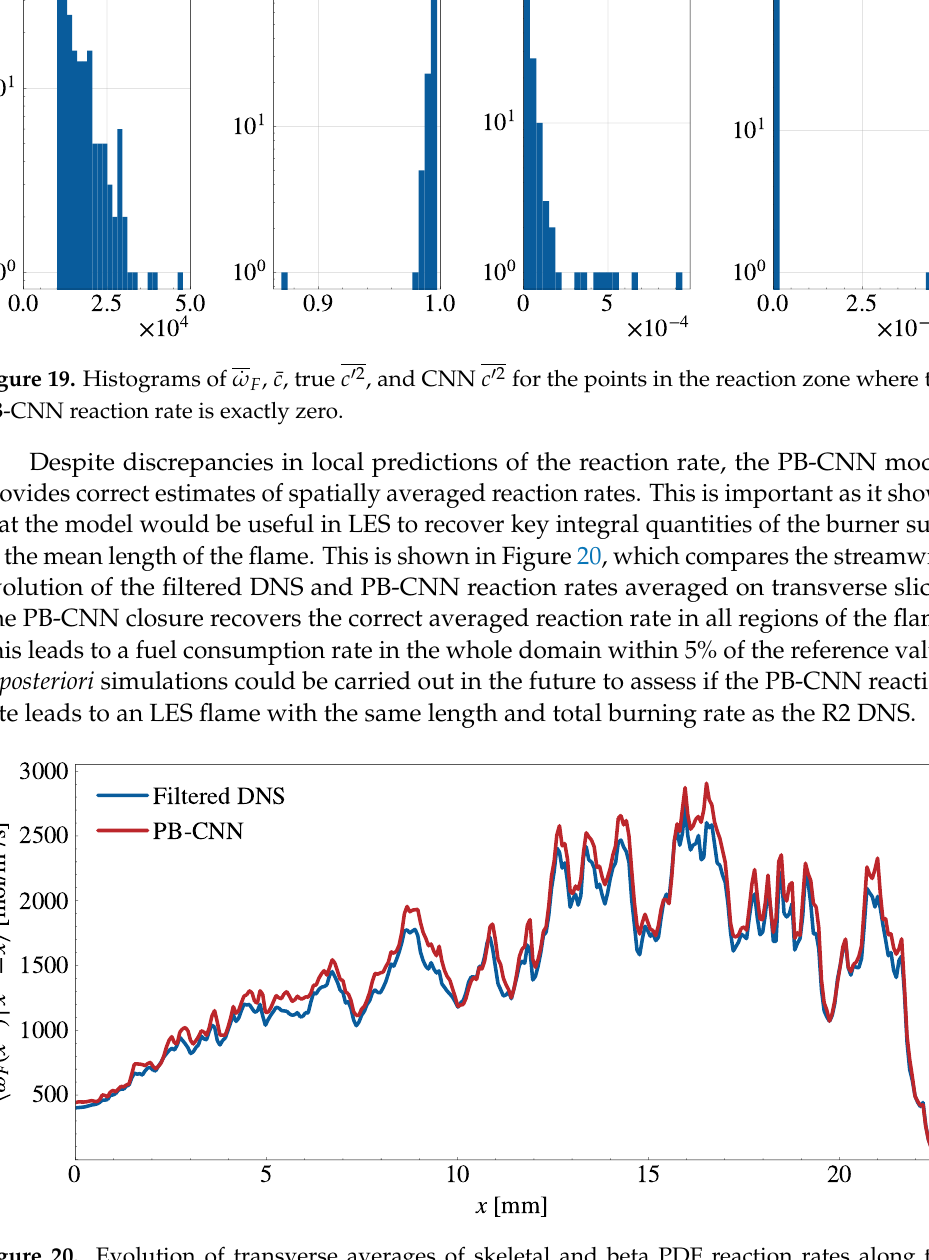
Figure 20. Evolution of transverse averages of skeletal and beta PDF reaction rates along the streamwise direction x